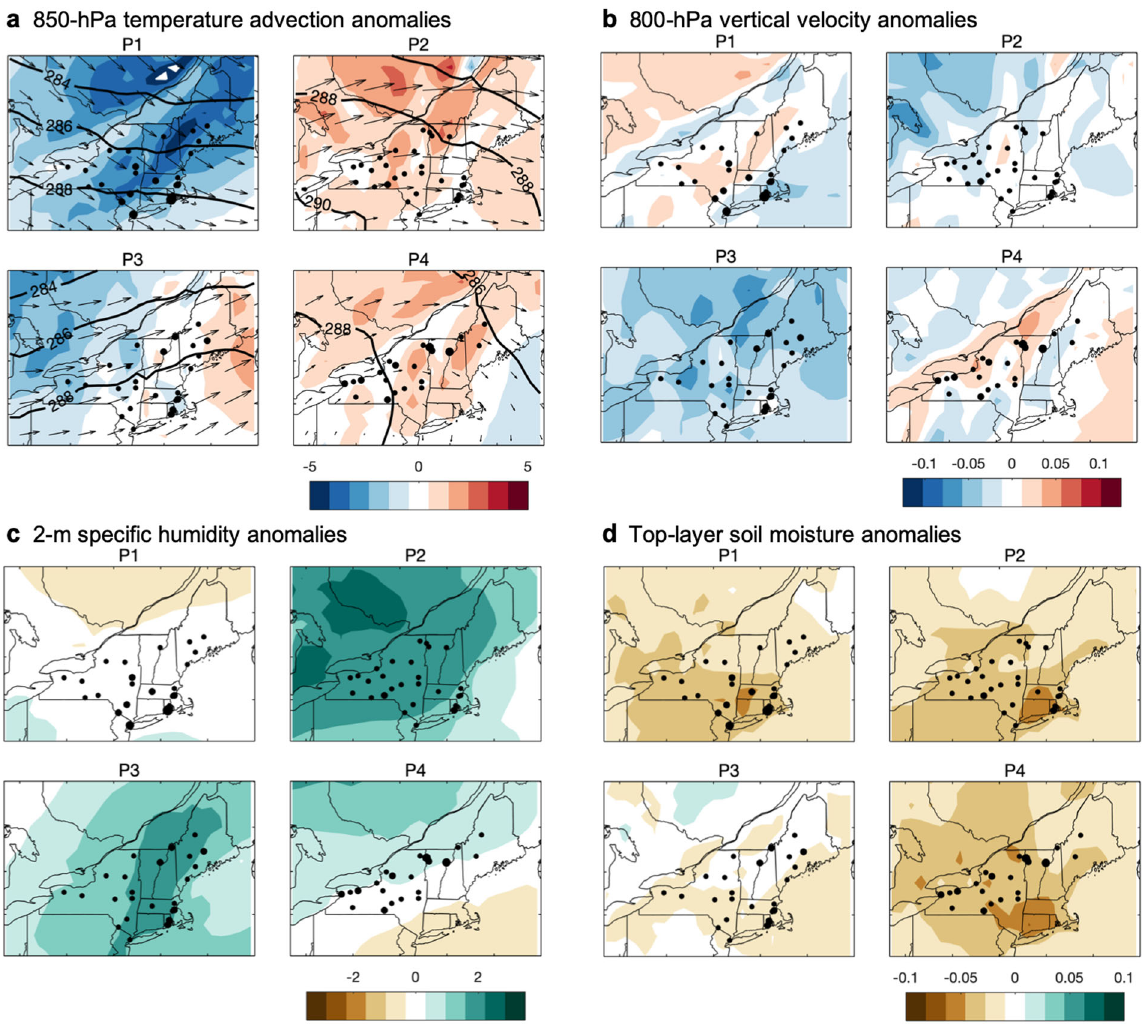
Fig. 2 Composites of other meteorological fi elds on regional heat wave days. Composites for P1 – P4 days of a 850-hPa temperature advection anomalies (shaded, in 1 × 10 − 5 K s − 1 increments) with 850-hPa temperature (contours, in 2 K increments) and 850-hPa winds (quivers, largest quiver 10 ms − 1 ), b 800-hPa vertical velocity anomalies (shaded, in 0.025 Pa s − 1 increments, such that anomalous subsidence is red), c 2-m speci fi c humidity anomalies (shaded, in 0.7 kg/kg increments), and d top surface layer soil moisture anomalies (shaded, in 0.02 increments). The black dots in each panel are identical to those in Fig. 1d, showing relative frequency of station heat wave days for each